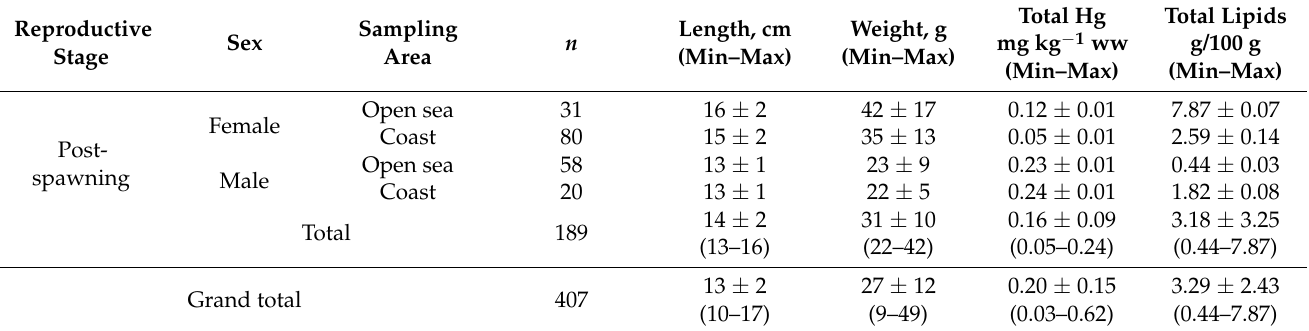
Figure 3. 2D biplot of PC1 vs. PC2. M: male; F: female; OS: open sea; C: coast; J: juvenile; A: adult; S: spawning; PS: post-spawning. The PCA extracted two significant, cross-validated principal components which ac- count for 93.75% of the variability in the original data (Table 2). The first principal com- ponent (PC1, 66.68%) is dominated by biometric parameters and lipid content (Table 2). Juvenile specimens showed the lowest values of weight, length, and lipid content (nega- tive scores), both for male and female. Considering the other reproductive stages, females (positive scores) were associated with higher biometrics values and higher lipid content